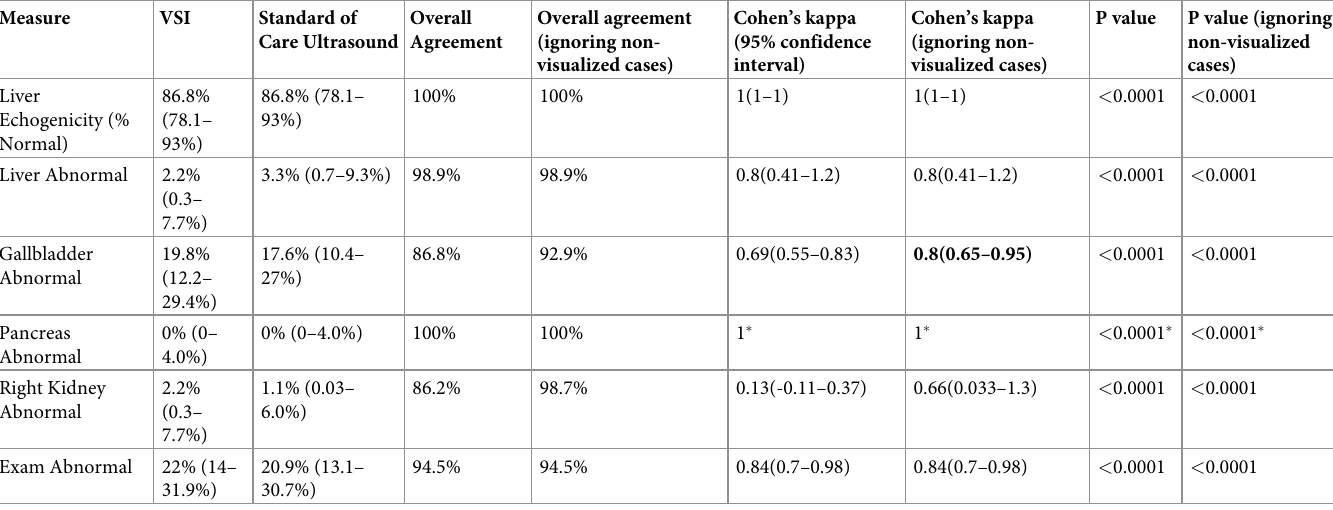
Table 2. Agreement between VSI and standard of care for acceptable/excellent image quality.